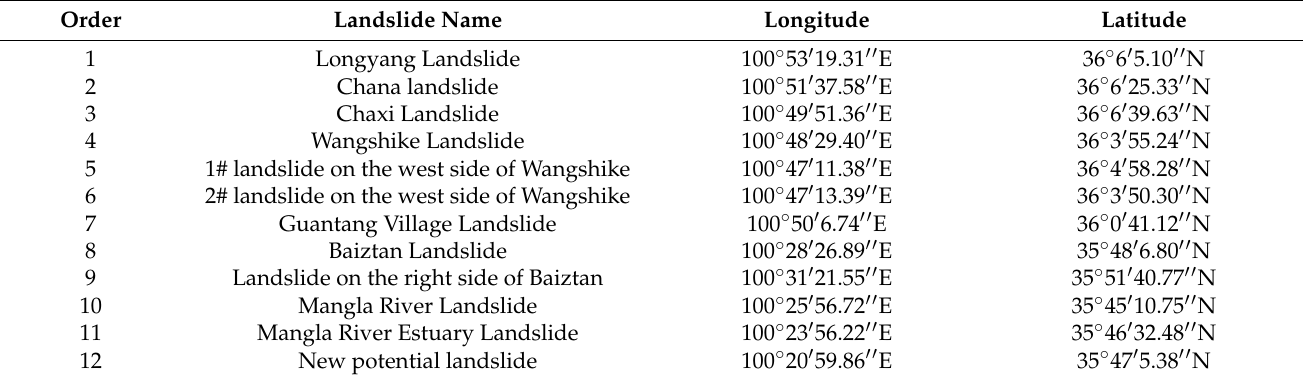
Figure 8. ( a ) Average displacement rate of Longyangxia Reservoir from 1 March 2017 to 21 March 2020; ( b ) eolian sand and shrub vegetation on the north bank of the reservoir; ( c ) sand dune landforms on the north bank. Table 5. List of potential landslides.